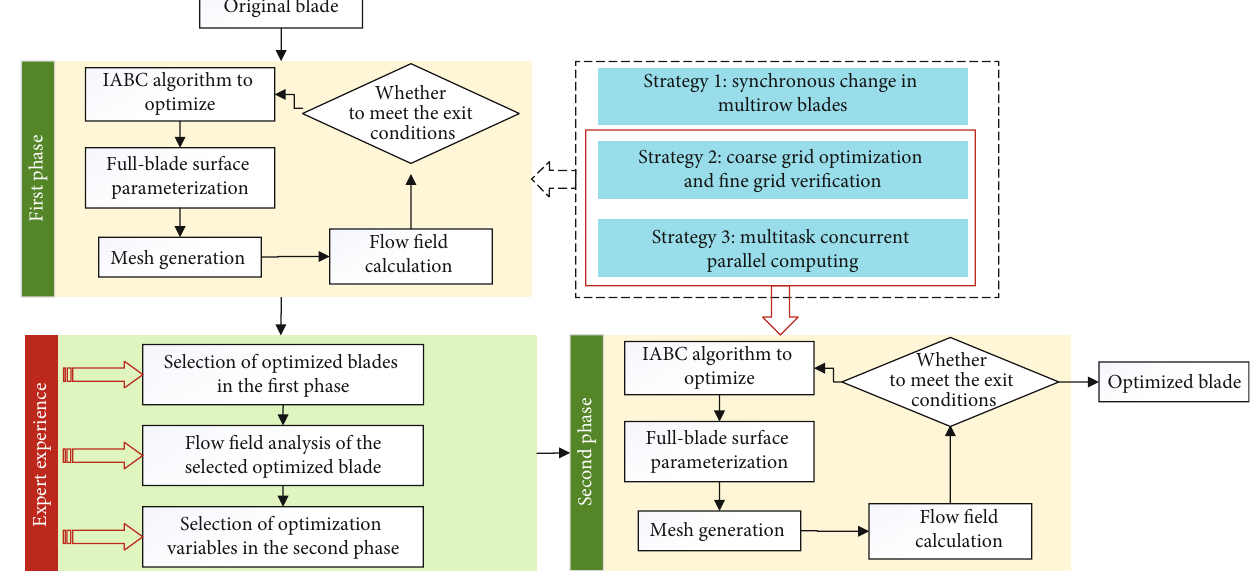
Figure 10: Schematic diagram of the optimization